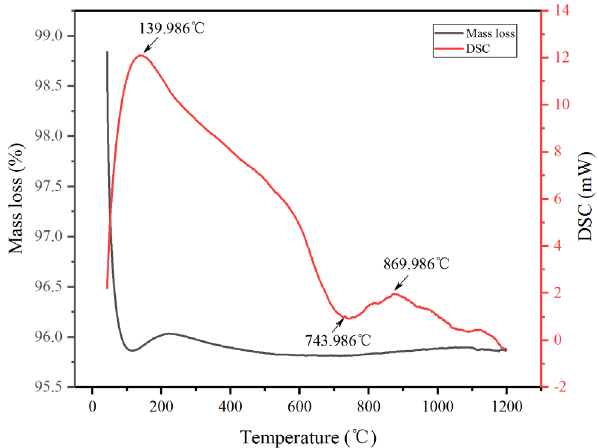
Figure 1. DSC pattern for FeCrMnNi